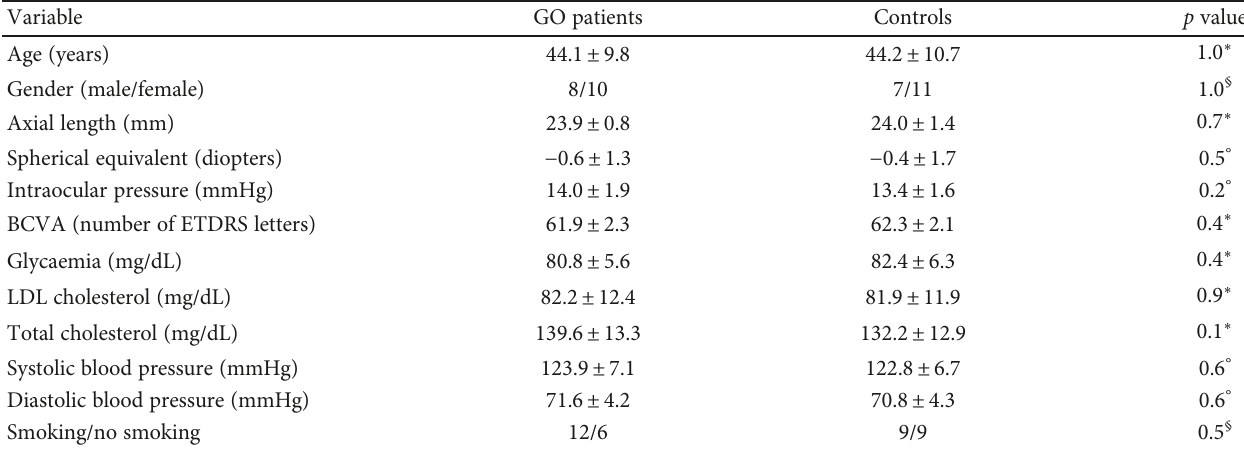
Table 1: GO patients versus controls: demographics and baseline clinical